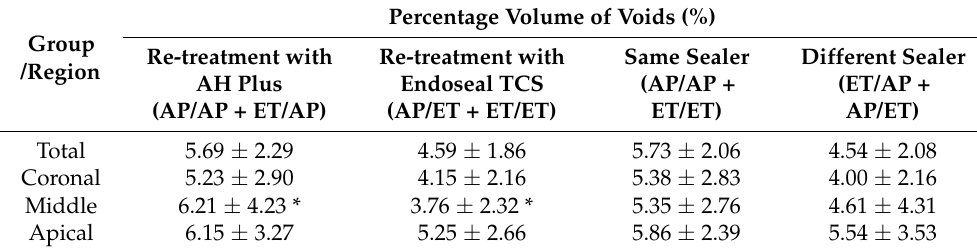
Table 3. Percentage volumes of voids (mean ± standard deviation) after re-obturation using AH Plus and Endoseal TCS, regardless of the previous sealer, and after re-obturation using the same or different sealers for initial treatment and re-treatment in the whole canal and each third.